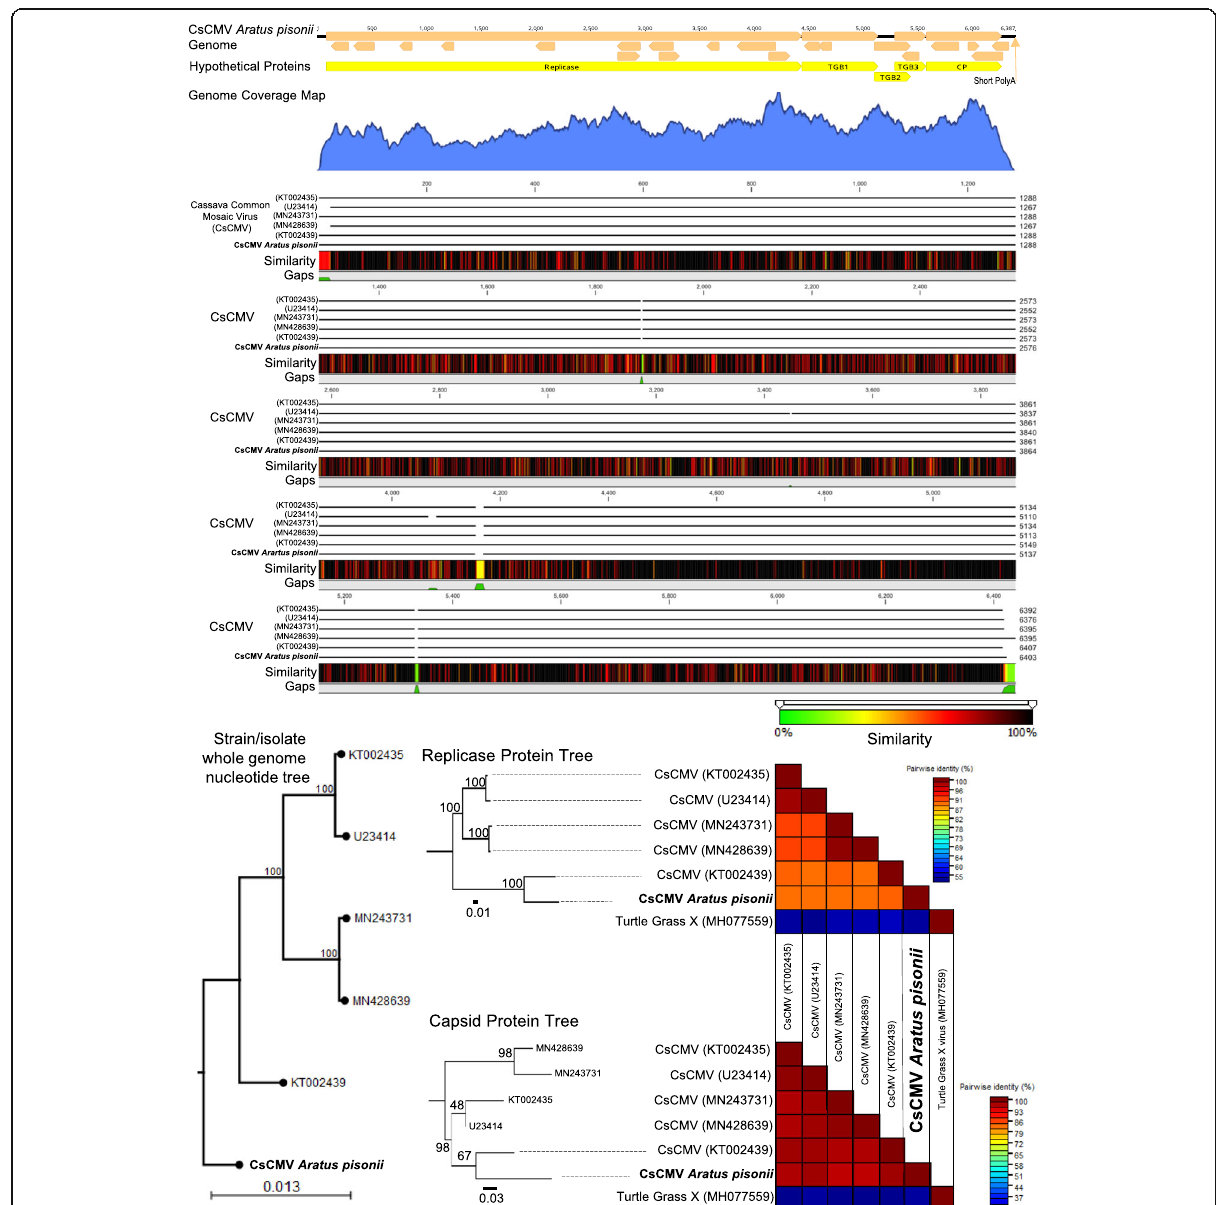
Fig. 2 Genomic annotation and similarity assessment of a novel Cassava Common Mosaic Virus (CsCMV) strain, mined from the Aratus pisonii metagenome data. The viral genome was identified from DNA data, suggesting it was reverse transcribed in the host cell. The genome represents all five of the open reading frames common to CsCMV, along with a short PolyA tail. Single nucleotide polymorphism comparison across the genome is presented, ranging from green (dissimilar) to black (similar). Whole genome nucleotide phylogenetics, replicase protein phylogenetics and capsid protein phylogenetics are present, as well as a pairwise comparison of both the replicase and capsid proteins across the strains. Graphics developed in CLC genomics workbench V. 20. Phylogenetic trees developed in IQtree. Similarity tables developed using Sequence Demarcation Tool V. haemobaphes nudivirus (DhNV) (1/91), and Macrobra- (Fig. 3; Table 2). The highest protein similarity, includ- chium rosenbergii nudivirus (MrNV) (1/91) (Table 2). ing lowest e-values, between existing Nudiviridae and Two proteins showed some similarity to proteins the new isolate was represented by similarity to Carcinus maenas nudivirus (CmNV) (44/91 genes), Homarus encoded by decapods, including a serine/threonine kin- gammarus nudivirus (HgNV) (27/91 genes), Penaeus ase (ApNV_020) ( Homarus americanus , 30.1%, 4e-10) monodon nudivirus (PmNV) (4/91), Dikerogammarus and ‘ GWK47_016212 ’ (ApNV_043) ( Chionoecetes opilio ,